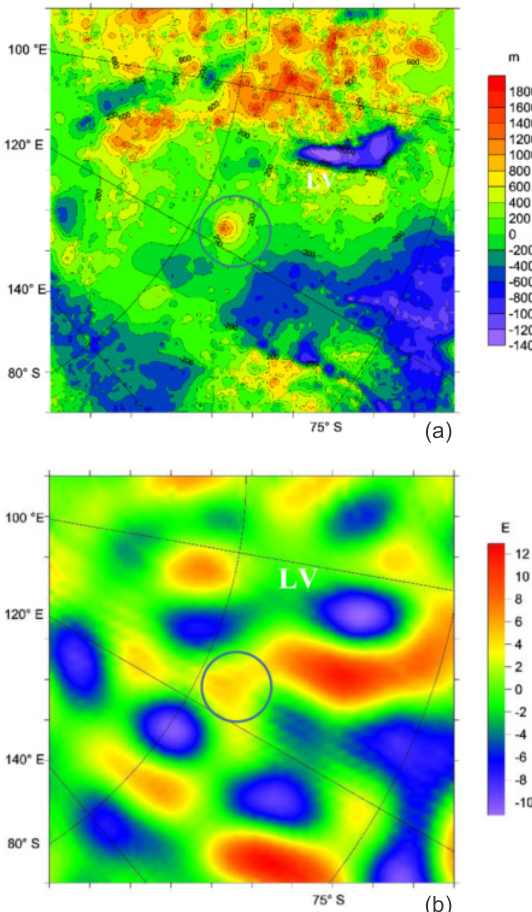
Figure 17 (same column, top to bottom). Topography according to Bedmap2 for the area of lake Vostok LV , (a) on left, and (b) T right. Note a possible volcano at the centre of the figures (encircled) and the correlation between (a) and